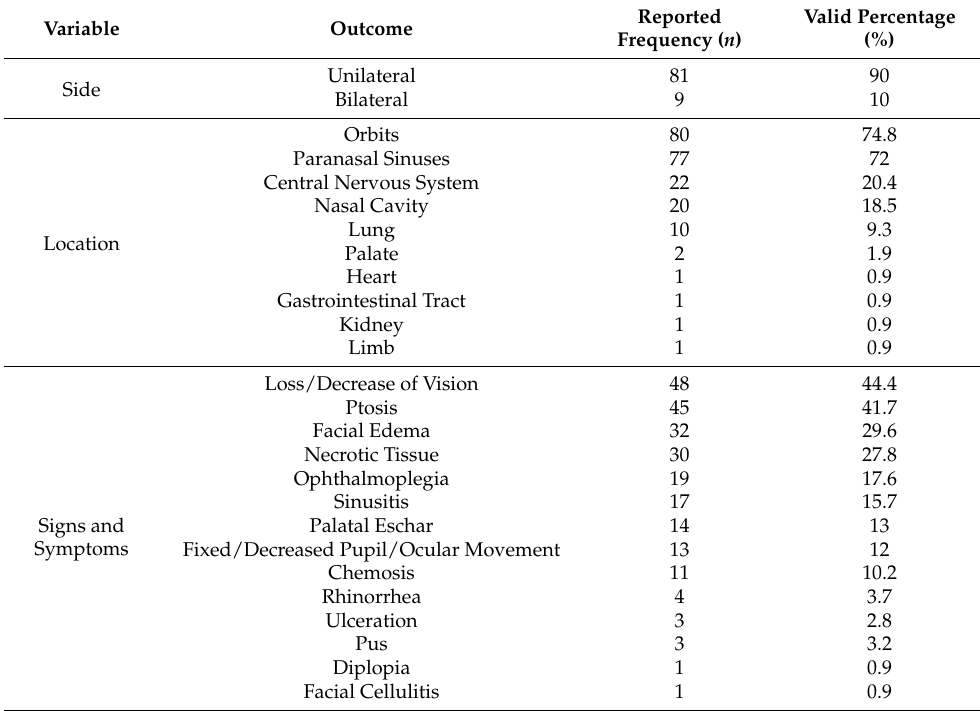
Table 4. Clinical Characteristics of COVID-19-associated Mucormycosis (CAM) Cases, Global Evi-